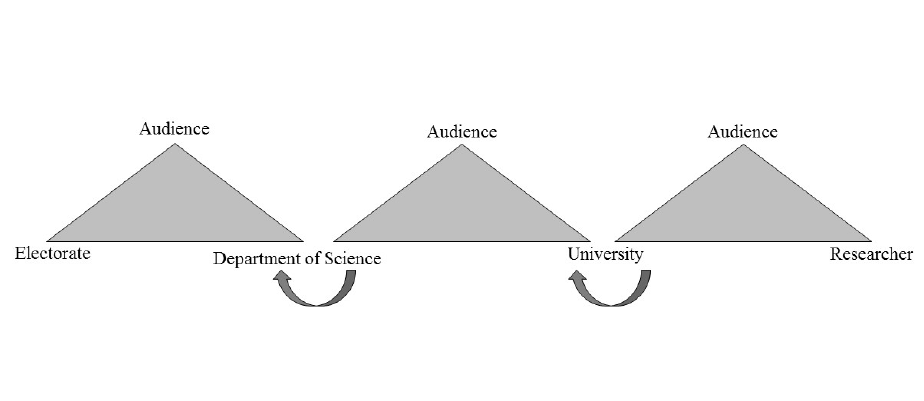
Figure 6 Signaling in competitive higher